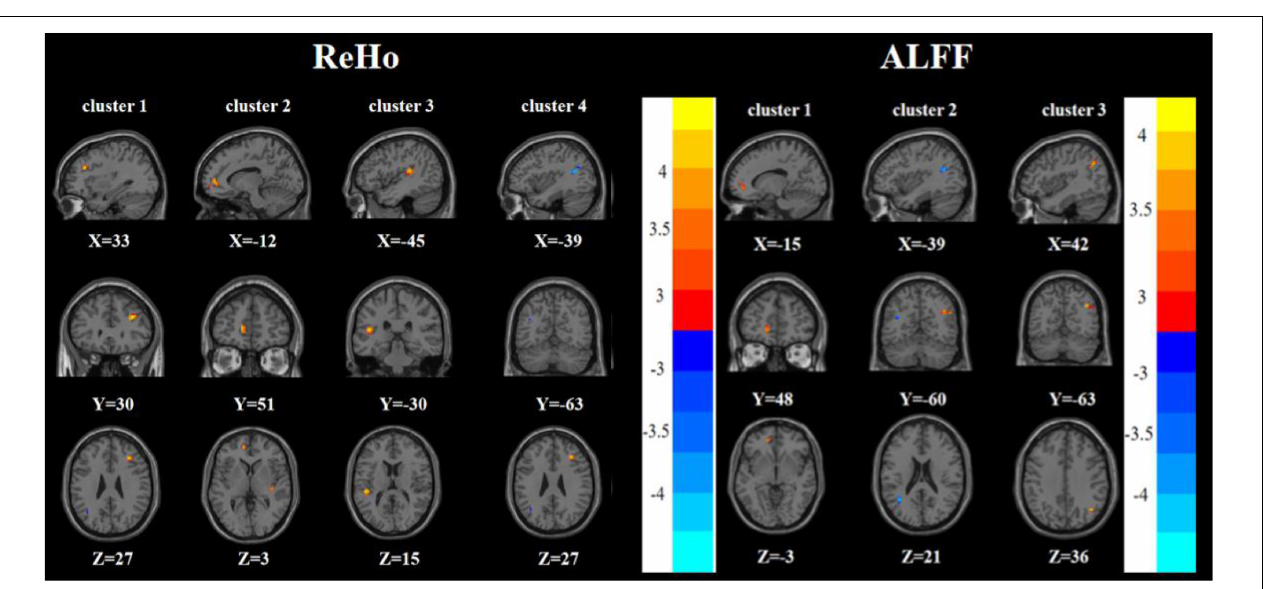
FIGURE 4 | Brain regions with abnormal ReHo (left) and ALFF (right) between the RDE group and the HC group based on a post hoc t -test. The color bars indicate the T